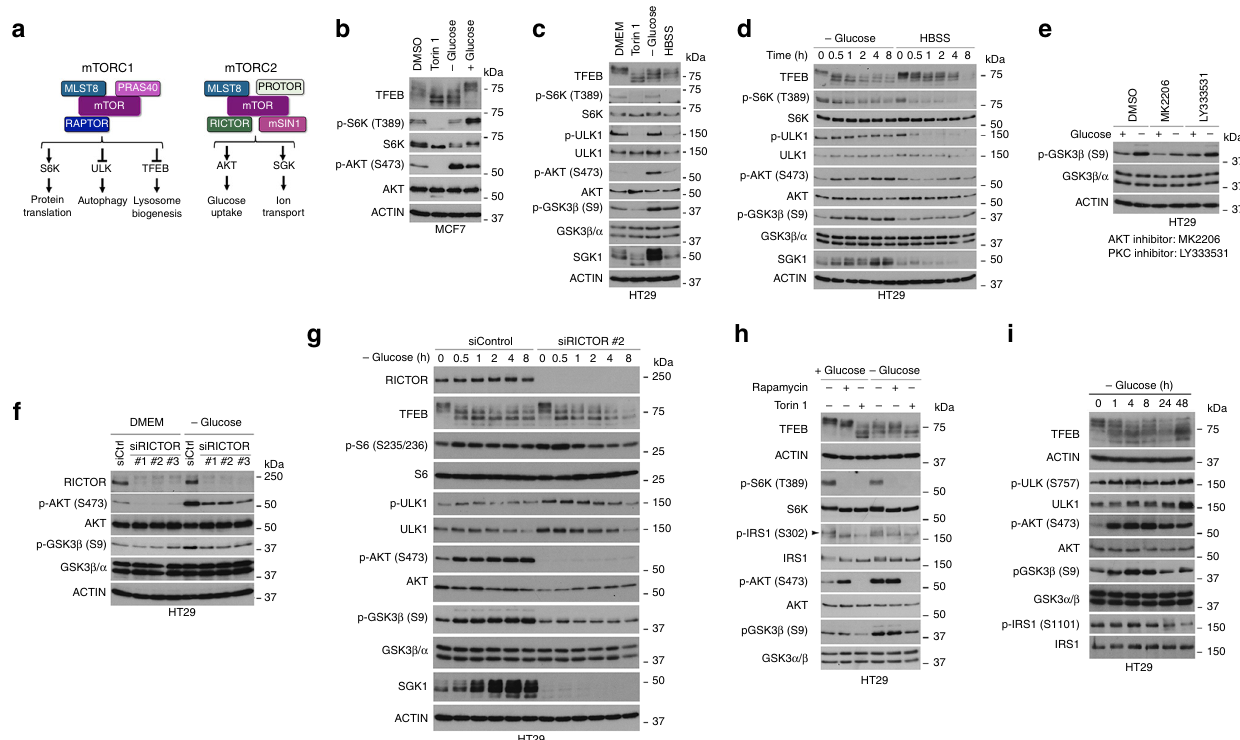
Fig. 7 mTORC2 regulates GSK3 β in response to glucose limitation. a Schematic showing the mTORC1 and mTORC2 complexes and downstream targets. b – d Western blots using indicated antibodies of HT29 cells grown under indicated conditions. Unless otherwise indicated cells were placed in HBSS for 2 h, or treated with Torin 1 (250 nM) or starved of glucose for 2 h and where indicted refed glucose for 1 h. e Western blot using indicated antibodies of HT29 cells grown in DMEM or starved of glucose for 4 h and treated with DMSO, MK2206 (3 μ M), or LY333531 (5 μ M). f Western blot using indicated antibodies of HT29 cells. 48 h after transfection with RICTOR-speci fi c or control siRNAs cells were glucose starved for 2 h, as indicated. g Western blot using indicated antibodies of HT29 cells transfected with control or RICTOR-speci fi c siRNA for 48 h prior to glucose starvation for indicated times. h Western blot using indicated antibodies of HT29 cells grown in the presence of absence of glucose (4 h) of cells treated with Rapamycin (1 μ M) or Torin 1 (250 nM). i Western blot using indicated antibodies of HT29 cells following glucose starvation for indicated